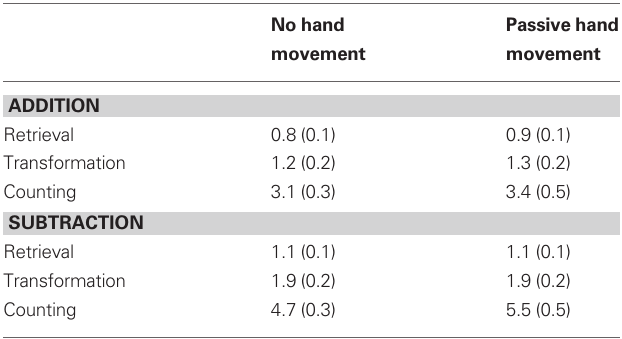
Table 2 | Reaction times (in seconds) as a function of Operation, Movement, and Strategy.